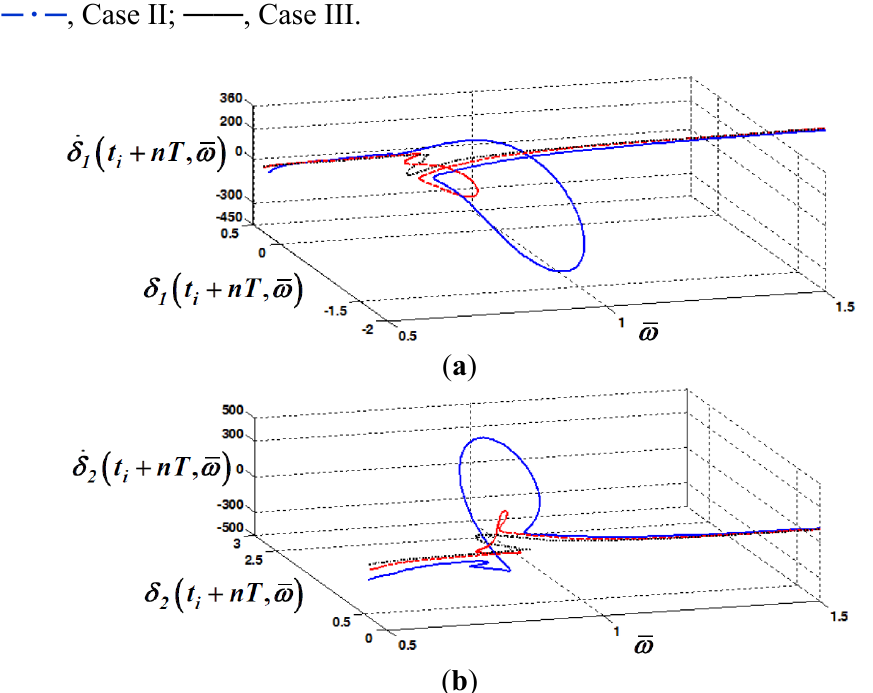
Figure 9. Comparison of Poincaré maps along with different excitation